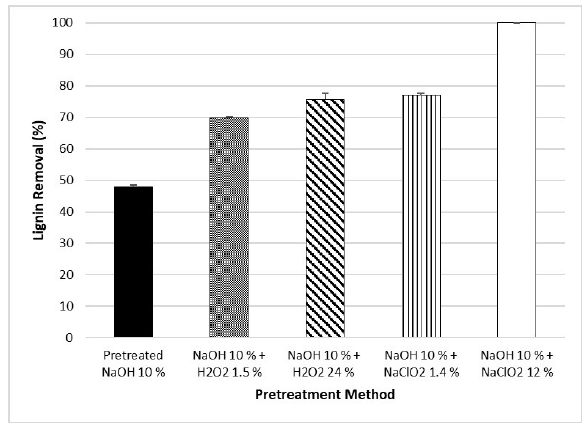
Fig. 2. The percentage of lignin lost in OPEFB after the pretreatment